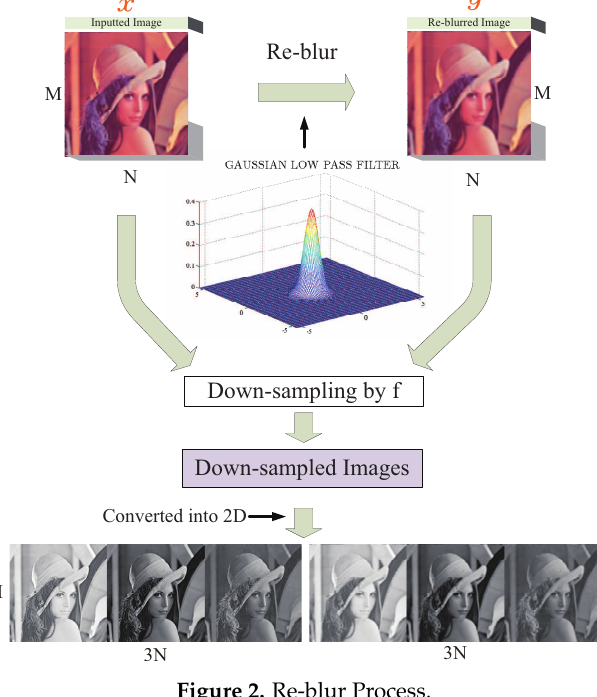
Figure 2. Re-blur